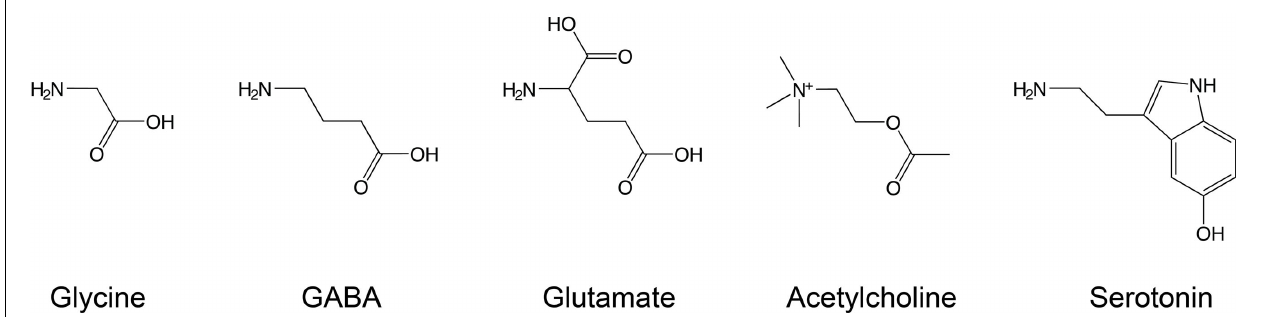
FIGURE 2 | Conventional Cys-loop receptor agonists. Glycine, GABA, and glutamate are neurotransmitters that bind to inhibitory receptors, while serotonin and acetylcholine bind to excitatory receptors. Note the different